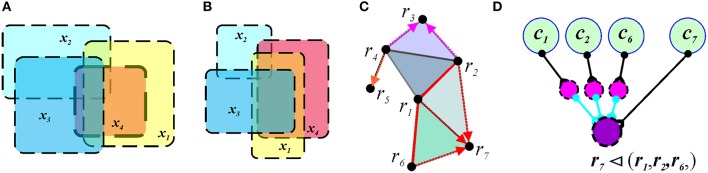
Mereological schema. In panels (A,B), the overlap pattern does not capture the cover relationship. Four regions, x1, x2, x3, and x4 form a quadruple overlap in both cases. However, in map shown in (A), the region x4 is contained in the union of x1, x2, and x3. In the map shown in (B), x4 is not covered. (C) The cover and the overlap relationships in a mereological schema corresponding to the map of Figure 1A. The covering regions are connected by red links (e.g., r6, r1, and r2) and the red arrows point to the covered region (e.g., r7). (D) A neuronal implementation of the covering relationship includes three inhibitory neurons (magenta) that provide inhibitory input into the readout neuron (purple). If each inhibitory input of an active interneuron exceeds the excitatory input of the driving cell c7, the readout neuron can spike only if the activity of the cell c7 is not accompanied by the inputs from any of the cells c1, c2, or c6. As a result, the readout neuron will remain silent as long as the activity of the cells c1, c2, and c6 temporally covers the activity of cell c7.